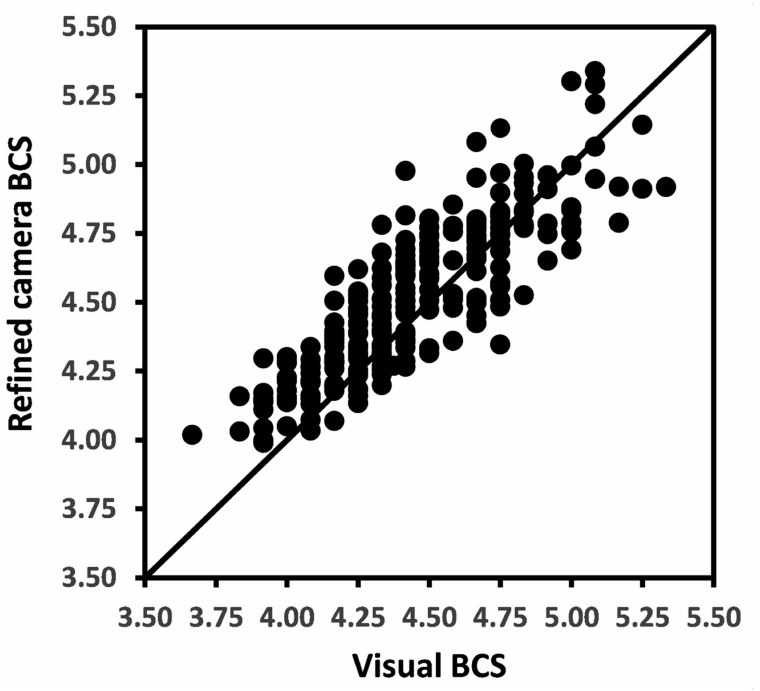
Figure 3. Scatter plot with each solid dot representing a weekly mean body condition score (BCS) for a cow by refined camera method versus visual measurement method. The solid line represents the line of agreement.